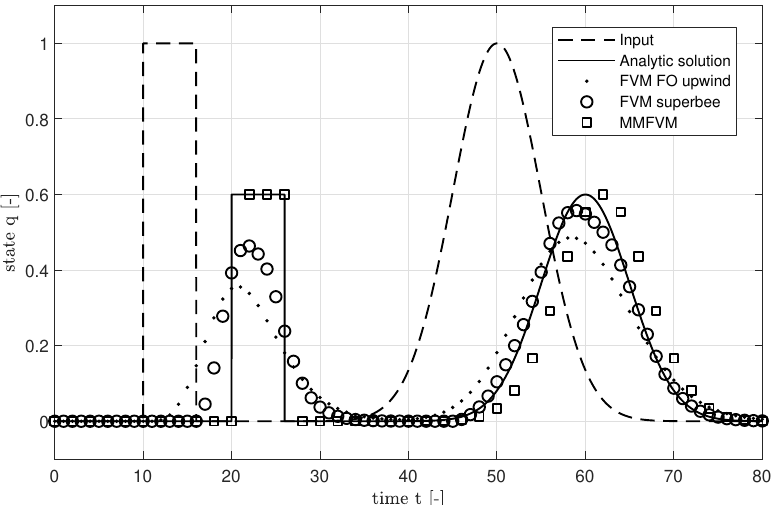
Figure 3. Method comparison for the advection-decay test at x = 1; number of volumes for all methods is N =